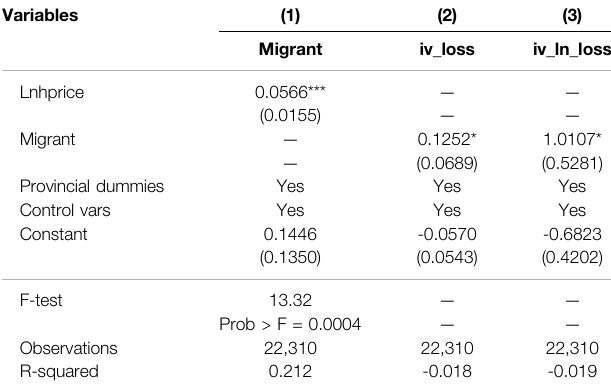
TABLE 7| IV Regressionofriskofhouseholds